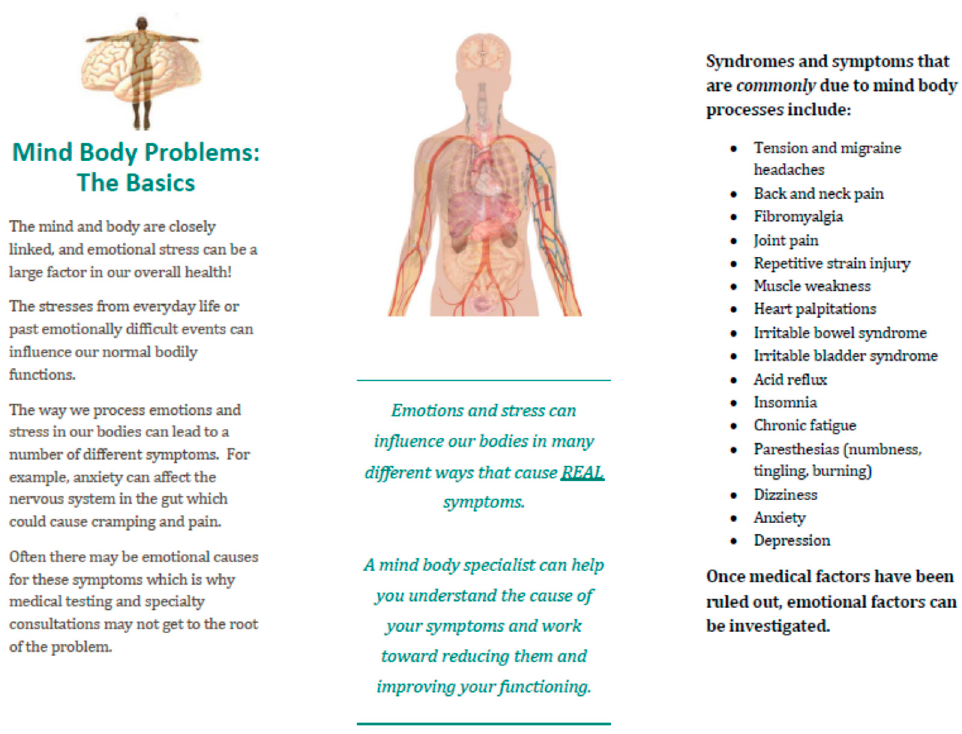
Figure A2. Patient Information Sheet (1).